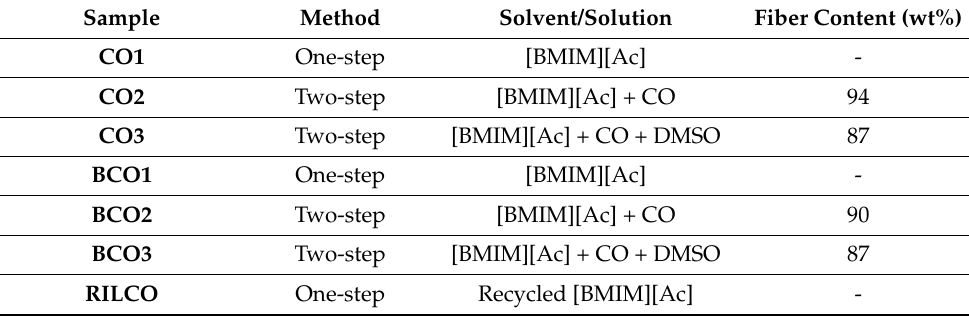
Table 1. Composition of the produced composites.